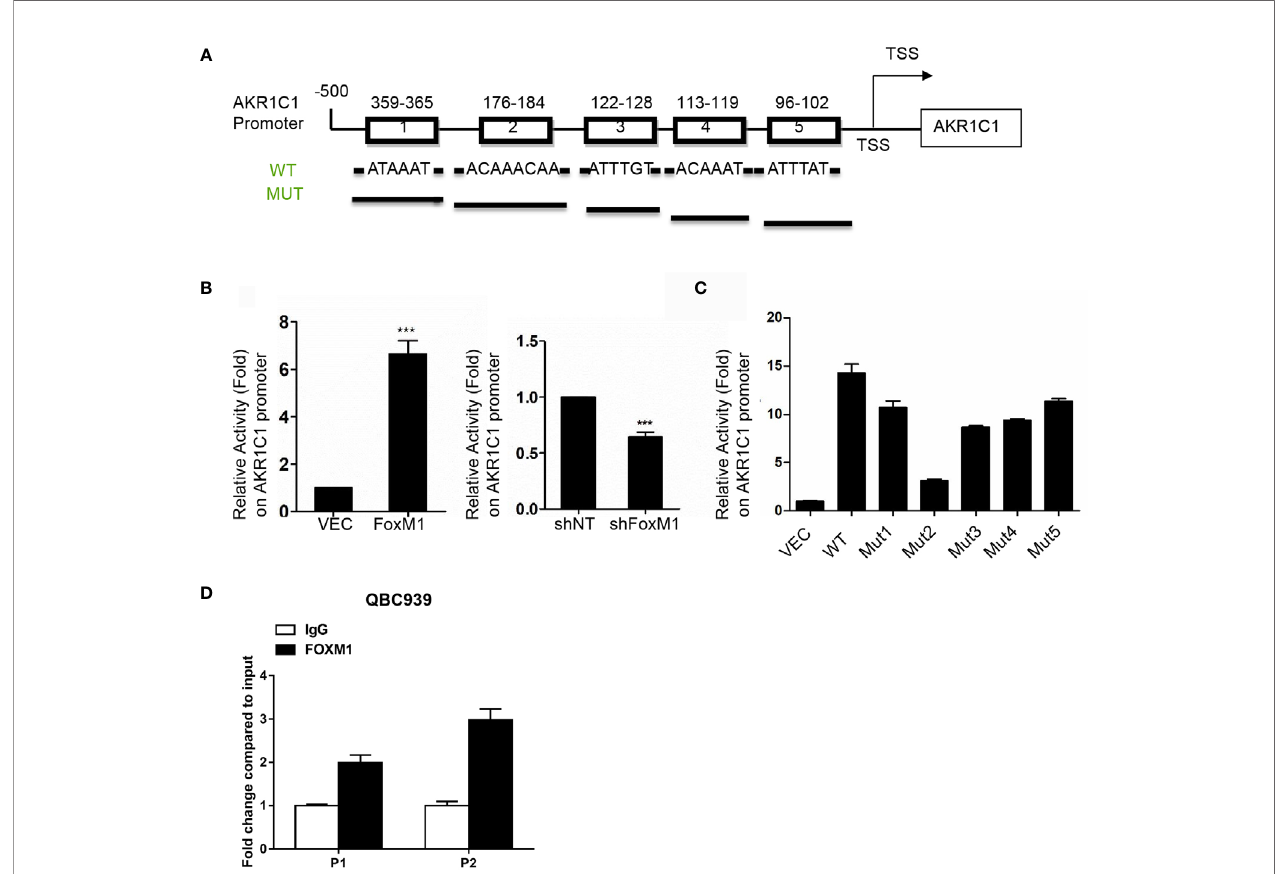
FIGURE 5 | AKR1C1 is a direct transcriptional target of FoxM1. (A) Diagram shows the sequence and position of fi ve putative FoxM1-binding elements in the AKR1C1 promoter. TSS, transcriptional start site; WT, wild type; Mut, mutant type. (B) Left panel, RBE cells were cotransfected with the AKR1C1 promoter reporter, pRL-TK, and pcDNA3.1-FoxM1 or pcDNA 3.1; right panel, RBE cells were cotransfected with the AKR1C1 promoter reporter, pRL-TK, and FoxM1-shRNA or shcontrol (50 nM). 36 hours after transfection, the cells were collected, and the relative AKR1C1 promoter activities were measured. The assay was repeated three times independently. ***P < 0.001. (C) Reporter plasmids harboring the wild-type AKR1C1 promoter or the corresponding mutant promoter in the FoxM1-binding sites were transfected into RBE cells, and the relative promoter activities were measured as above. (D) The chromatin immunoprecipitation (ChIP) assay results show the in vivo binding of FoxM1 to the AKR1C1 promoter. QBC939 cell lysis was immunoprecipitated using an anti-FoxM1 antibody or immunoglobulin G The resulting samples were subjected to RT-PCR using the site-speci fi c